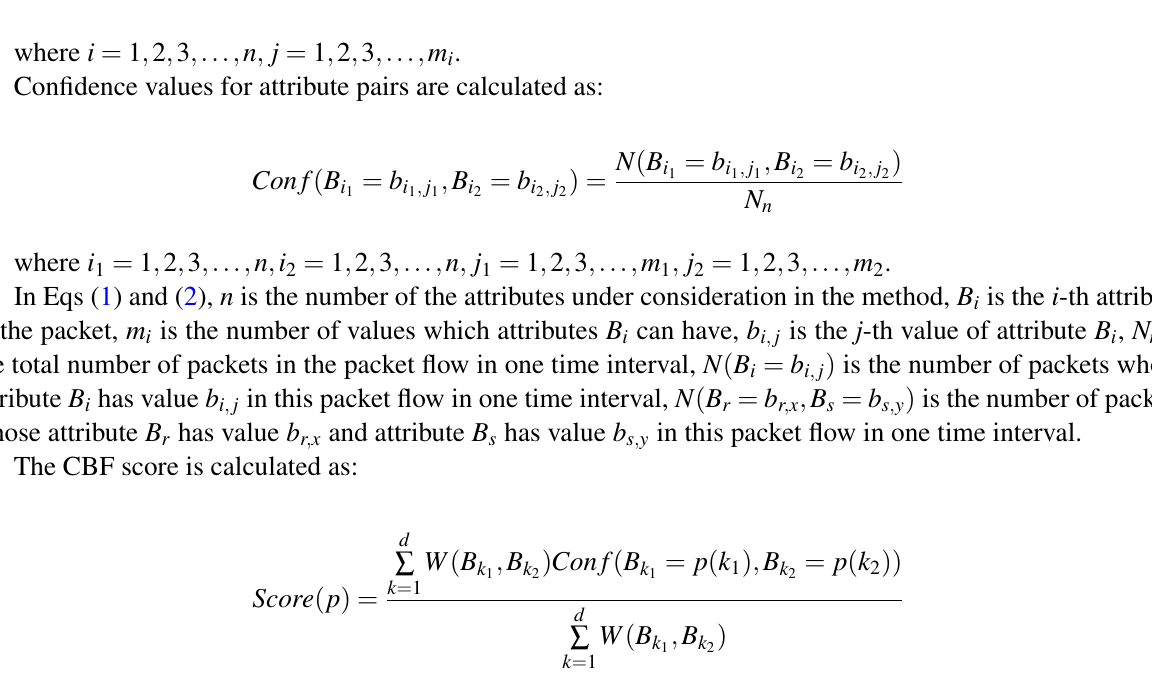
Fig. 6 The number of packets in S1 with load